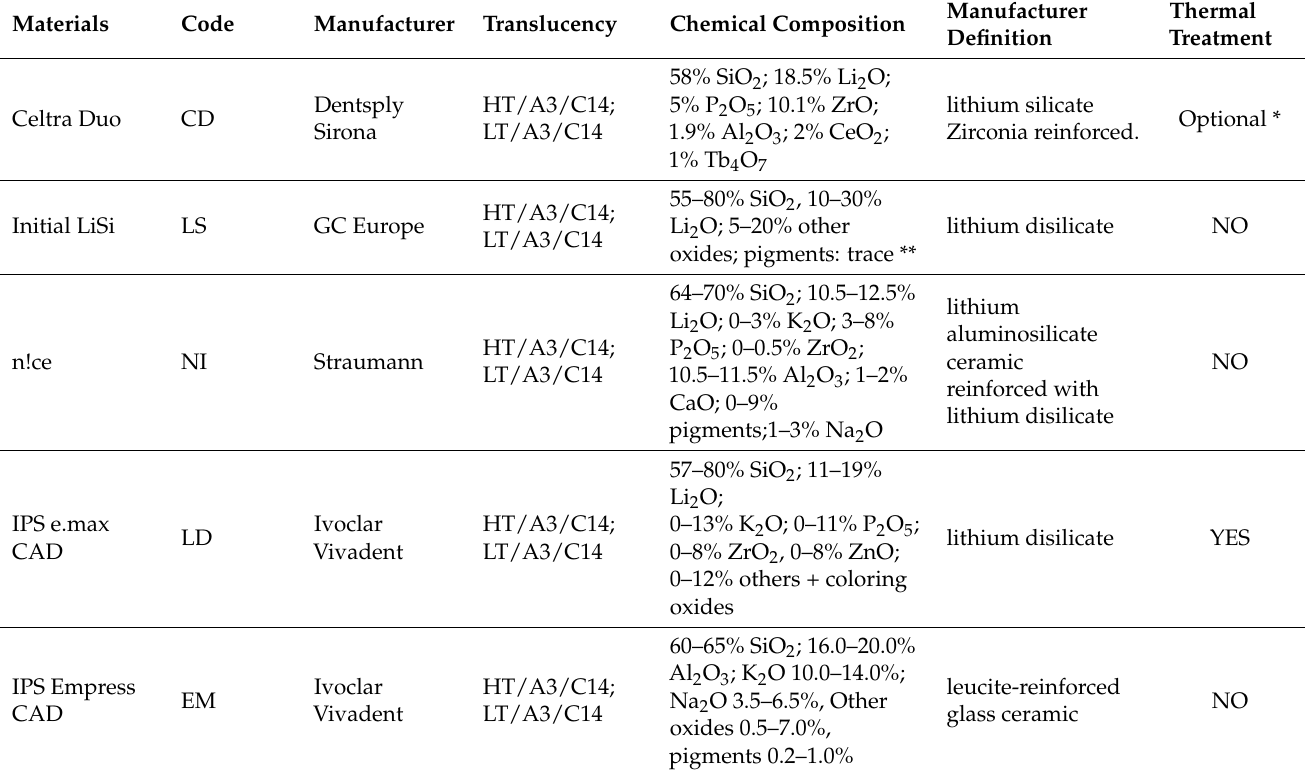
Table 1. Composition of the materials tested (manufacturers’